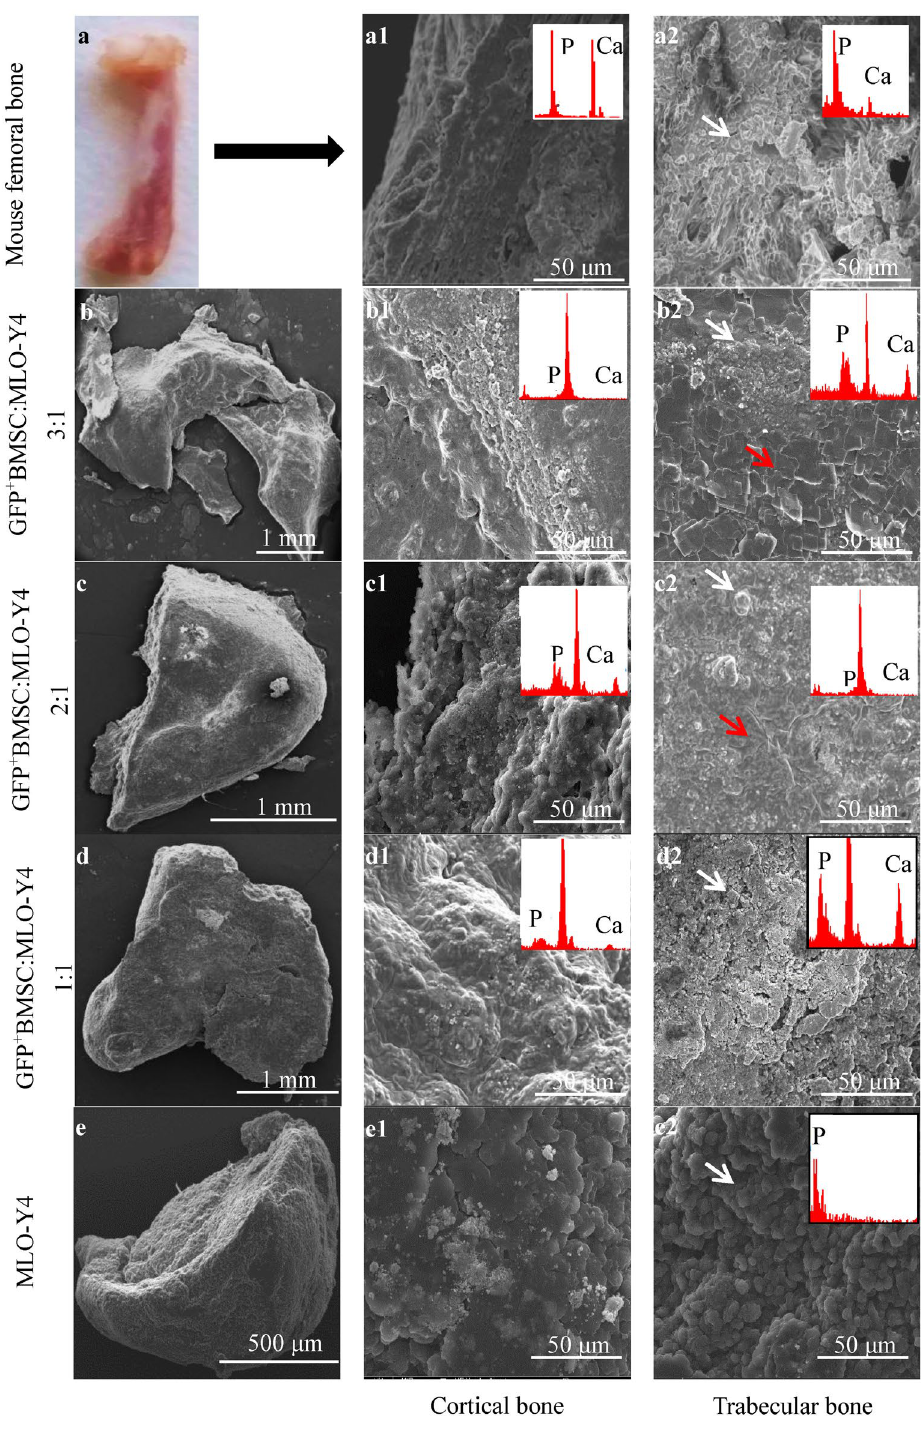
Figure 2. SEM morphology of the cross-sections of bone-like tissues and mouse femoral bone. Continuous dense layers of deposited calcium phosphate and ECMs were observed in the mouse femoral cortical bone ( a1 ) and with GFP + BMSC:MLO-Y4 3:1 ( b1 ), 2:1 ( c1 ), and 1:1 ( d1 ), but not with the MLO-Y4 monoculture ( e1 ). Spherical calcium phosphate was observed in mouse femoral trabecular l bone ( a2 ) and all of the spheroid cultures ( b2 – e2 , white arrowheads). Flake-like calcium phosphate was present in the 3:1 ( b2 ) and 2:1 ( c2 ) co-cultures (red arrowheads). SEM, scanning electron